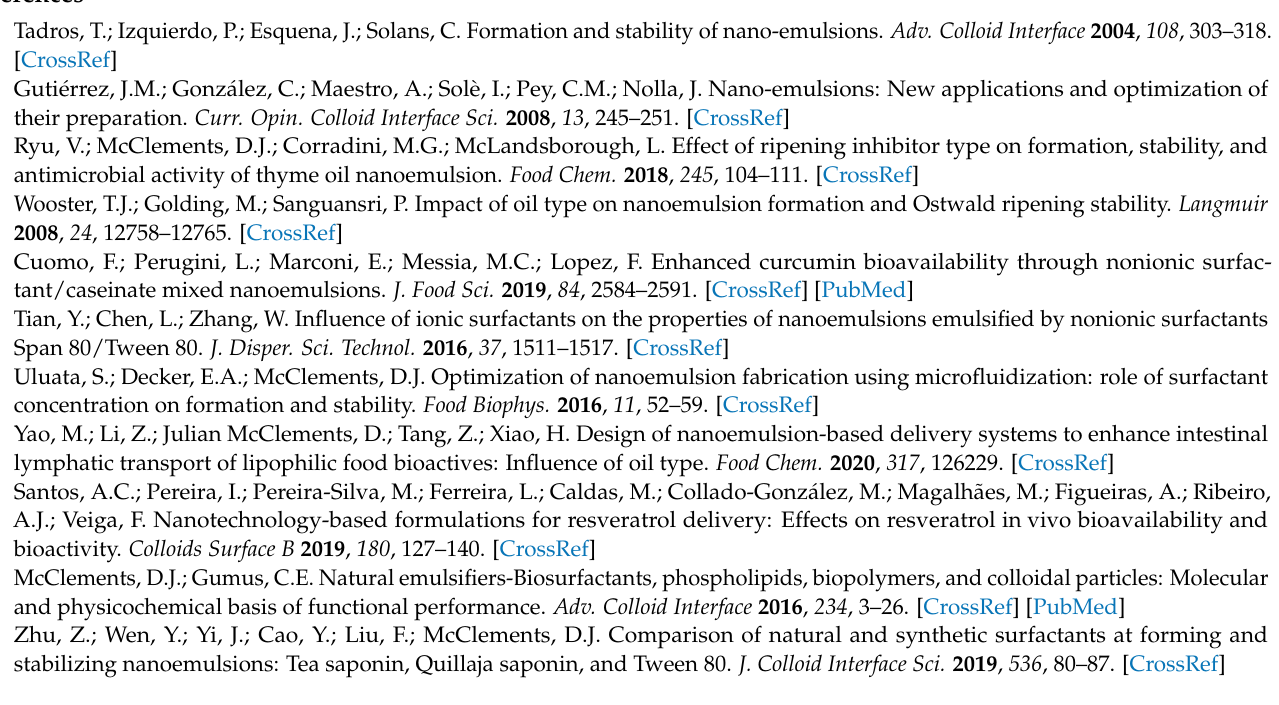
Supplementary Materials: The following are available online. Table S1: The original data of Figure 1. Table S2: the original data of Figure 2. Table S3: The original data of Figure 3. Table S4: The original data of Figure